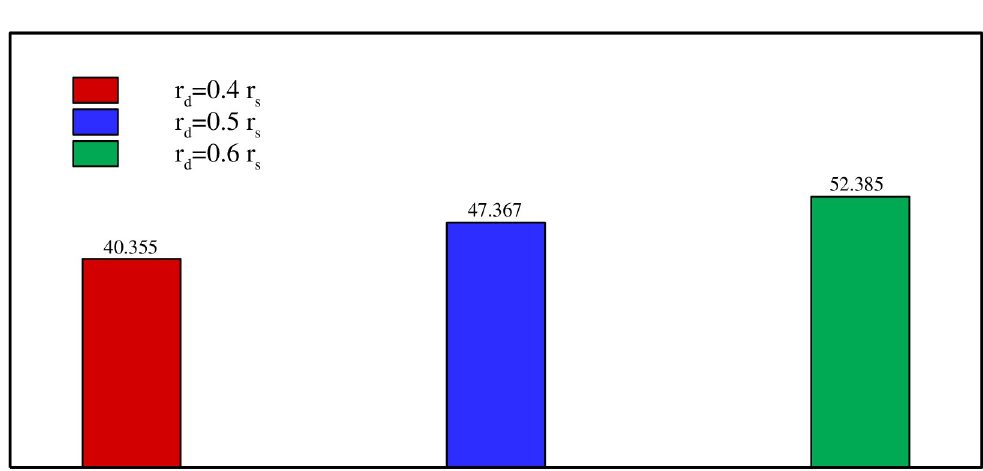
Fig 19. Comparison between the powers (W/m) on various r